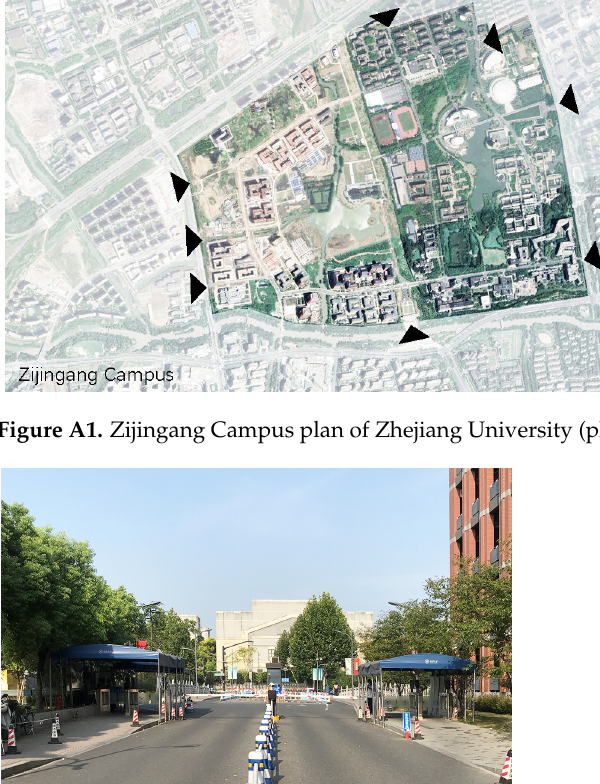
Figure A3. Fences around Zijingang Campus and separated campus couples (photo taken on 5 De- cember 2021).